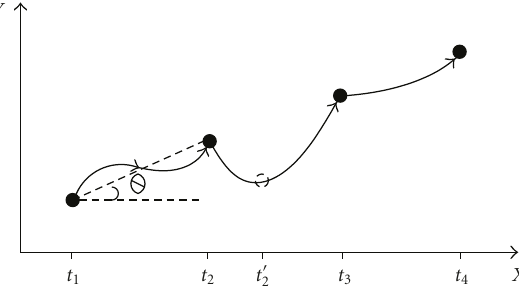
Figure 2: An example of direction